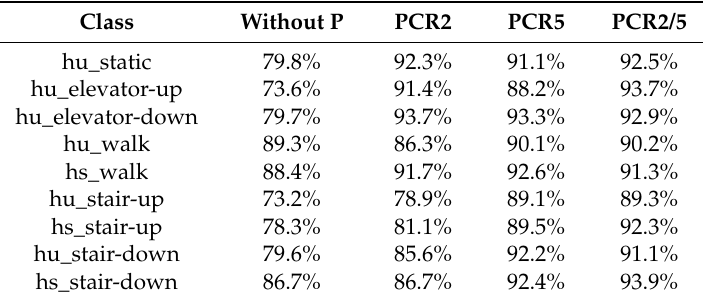
Table 8. Each motion recognition accuracy using